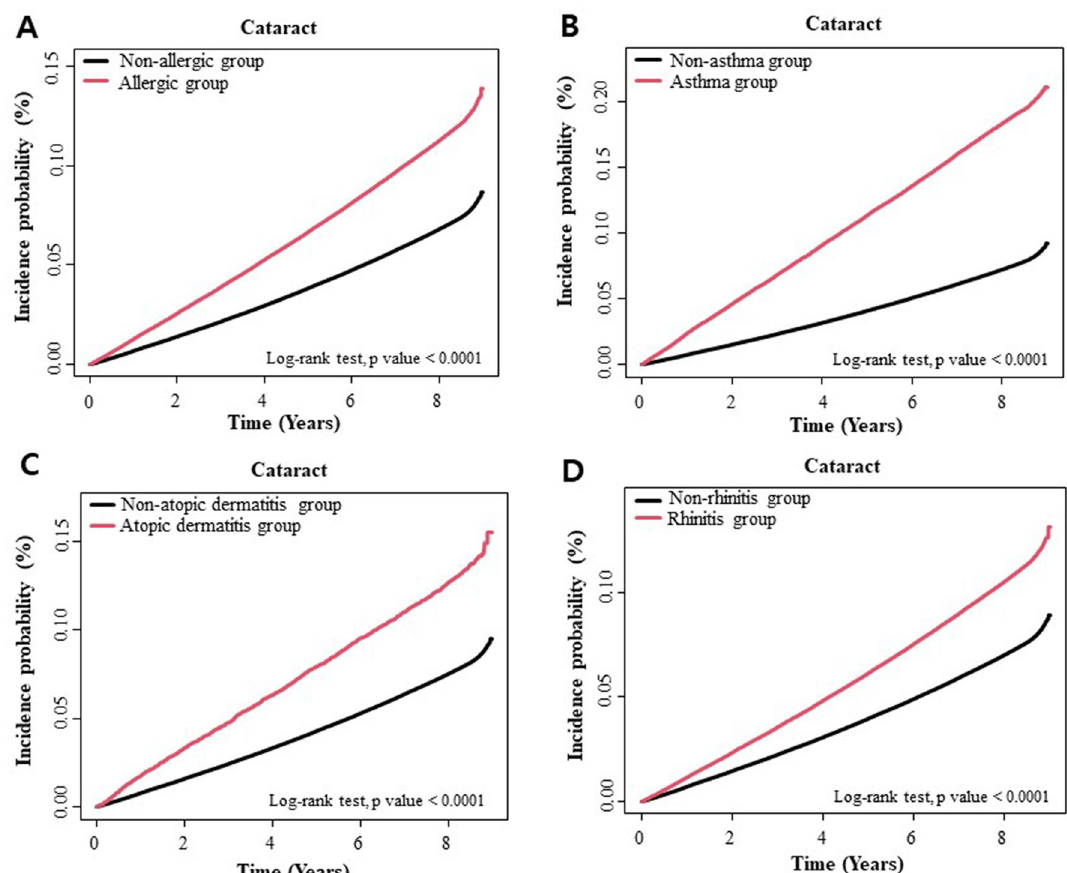
Figure 1. Comparison of cumulative incidence probability of cataract according to the allergic disease ( a ), asthma ( b ), atopic dermatitis ( c ), and allergic rhinitis ( d ). The incidence probability of cataract increases more over time in the allergic group than in non-allergic group for all different kinds of allergic